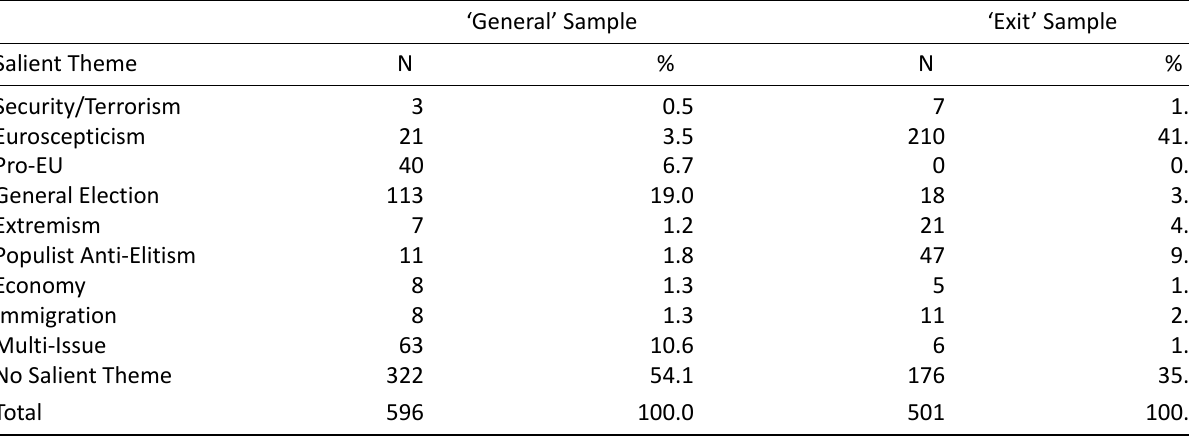
Table 2. Frequency of thematic categories across both